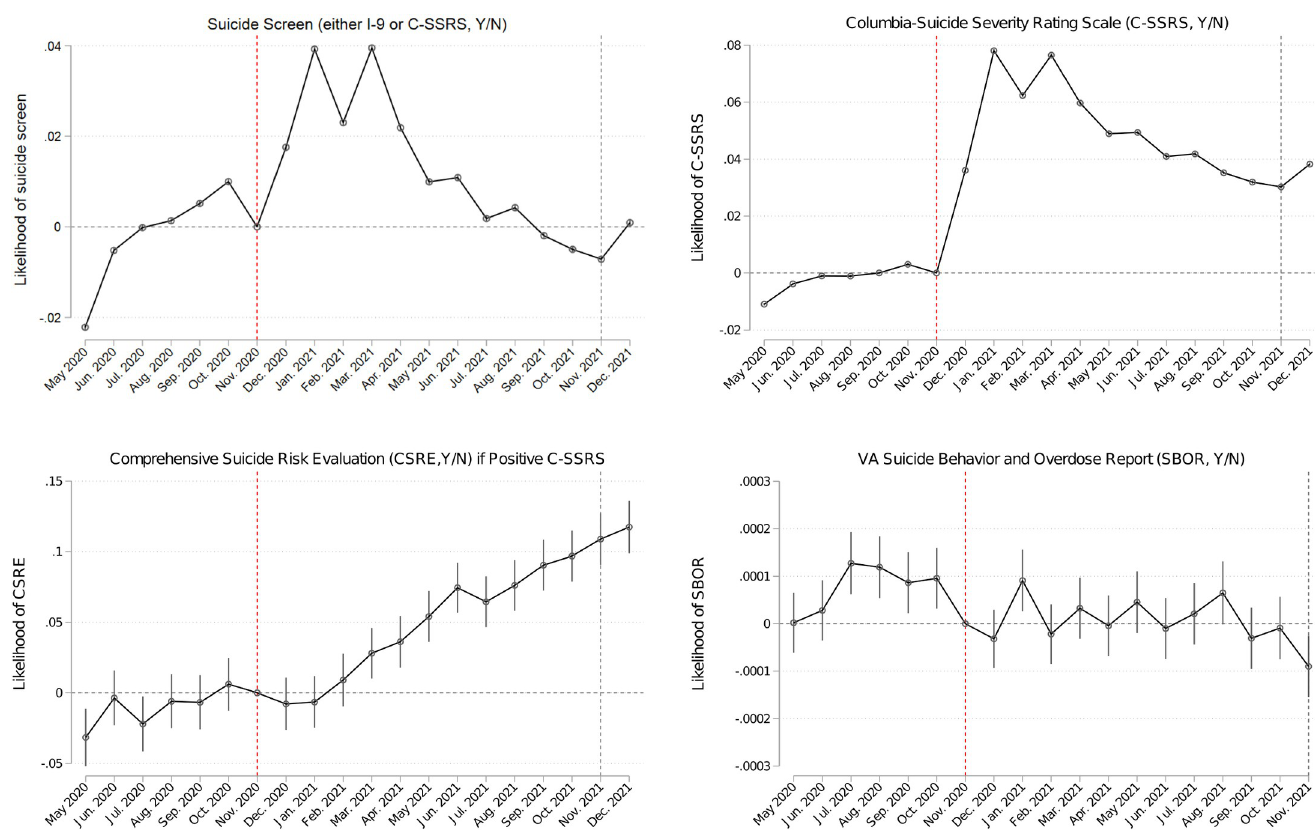
Fig 2. Model-adjusted outcome differences compared to Nov. 2020 –monthly coefficients from regression analyses. Note: Analyses not conditioned on positive C-SSRSs included 1,654,180 Veterans and 33,083,600 Veteran-monthly observations. Analyses conditioned on positive C-SSRSs included 57,673 Veterans and 85,237 Veteran-monthly observations. All models adjusted for Veterans’ age, sex, race, ethnicity, rurality of residence, number of physical and mental health chronic conditions, diagnoses of substance use disorder, post-traumatic stress disorder and depression, Nosos score, VA priority-based enrollment, marital status, homelessness indicator, high suicide risk indicator, cumulative monthly COVID-19 cases in the patient’s county. All models included indicators for patients’ closest facility to control for any time-invariant facility characteristics. In sensitivity analyses, models also adjusted for broadband coverage in patients’ residential zip-codes.